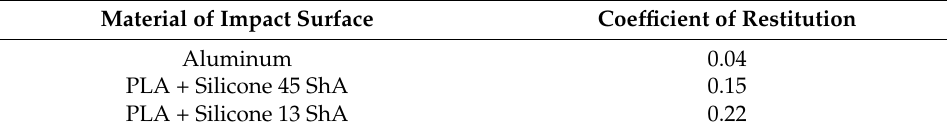
Table 2. Measurements from the edge collision test rig.